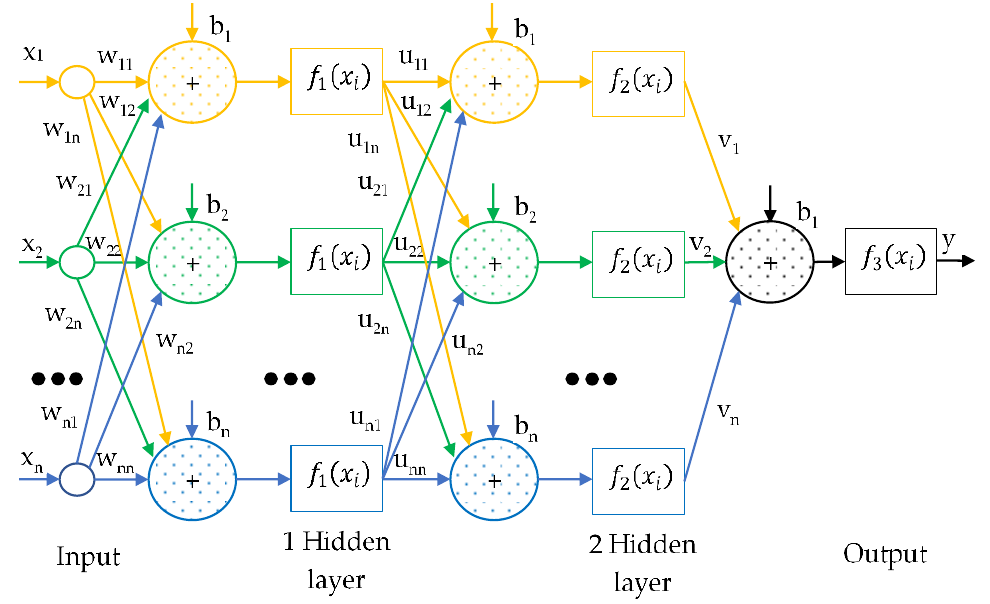
Figure 1. General schematic of the applied structure of the neural network.